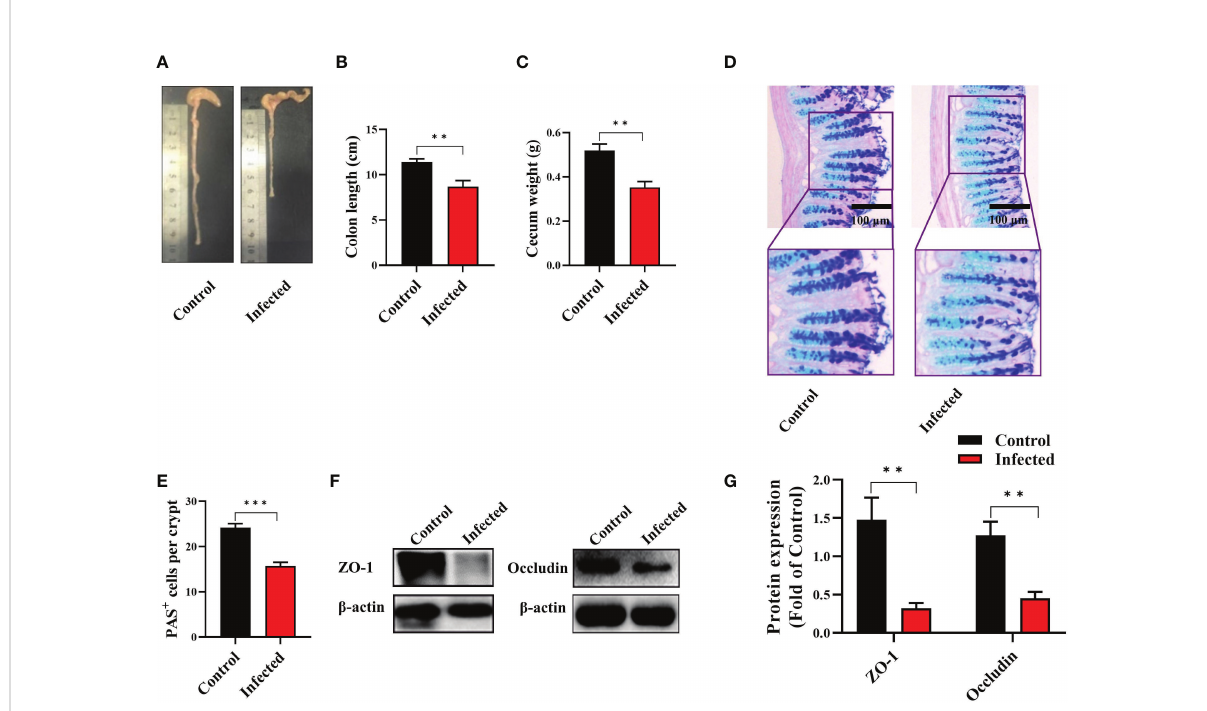
FIGURE 1 The protoscoleces of Echinococcus granulosus infection disrupted colonic epithelial barrier function in mice. The C57BL/6J mice were sacri fi ced 7 months post infection, colonic samples were collected for multiple analysis. (A) The representative images of colons. (B) The colon length (n = 6). (C) The cecum weight (n = 6). (D) Intestinal goblet cells and mucus were shown by PAS staining (n = 3, scale bar: 100 m m). (E) Number of PAS + cells (goblet cells) per crypt. (F, G) Protein expression levels of ZO-1 and occludin in the colon (n = 4 - 6). The differences were analyzed using t-test. Values are presented as mean ± SEM. ** P < 0.01, *** P <